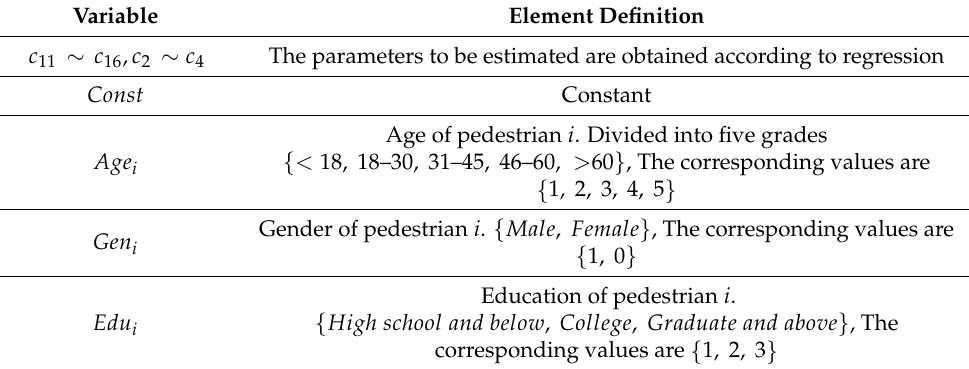
Table 2. Variable Definition of